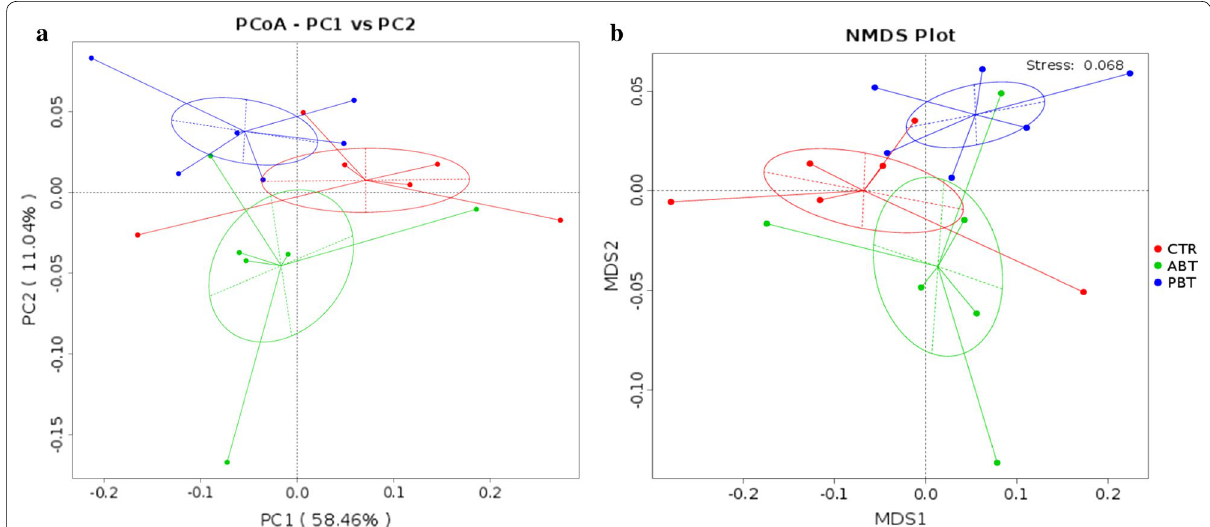
Fig. 2 Effects of dietary B. subtilis supplementation on colonic microbial community structures of piglets. a Represents PCoA analyze based on the weighted UniFrac distance matrixes, b represents NMDS analyze based on the weighted UniFrac distance matrixes